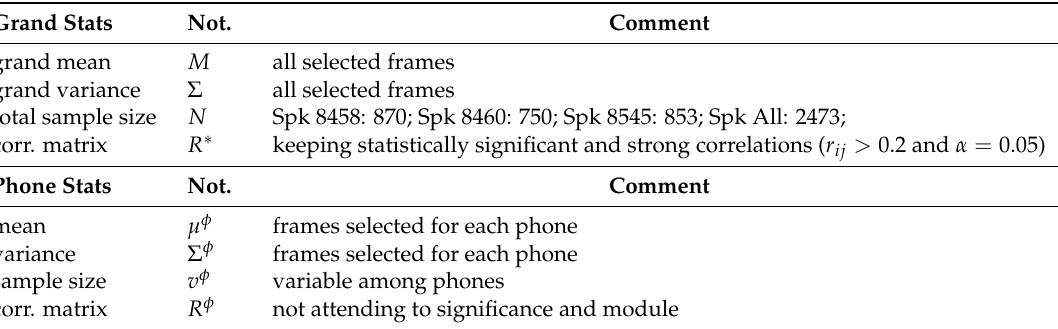
Table 2. Summary of the computed statistics for each landmark and corresponding notation as in Reference